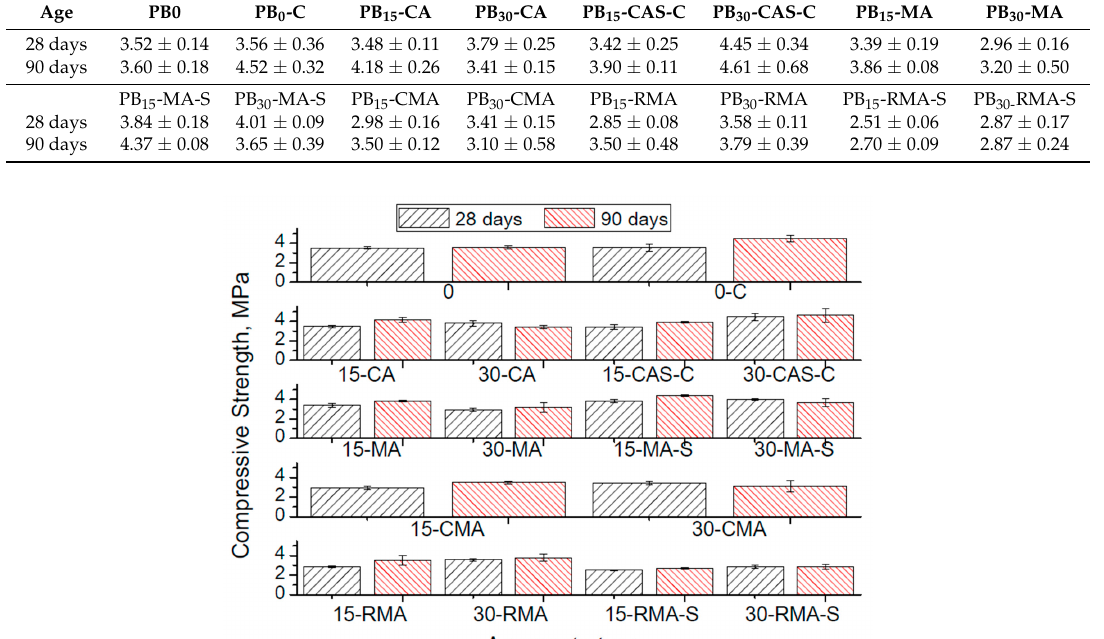
Table 6. Results of compressive strength, MPa, of paving blocks, as a function of the aggregate type, dosaging method (see Table 5 for nomenclature), and time.